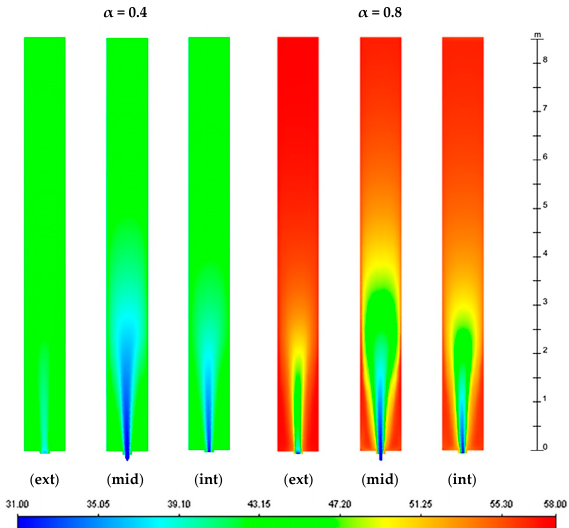
profiles inside the cavity are reported in Figure 16: the absorption coefficient halving leads to a 10 °C temperature reduction on the cavity faces (the external and internal faces tem- peratures decrease respectively from 55.7 °C to 44.7 °C and from 53.4 to 43.4 °C) and to a better temperature uniformity along the façade height (and the different building floors).